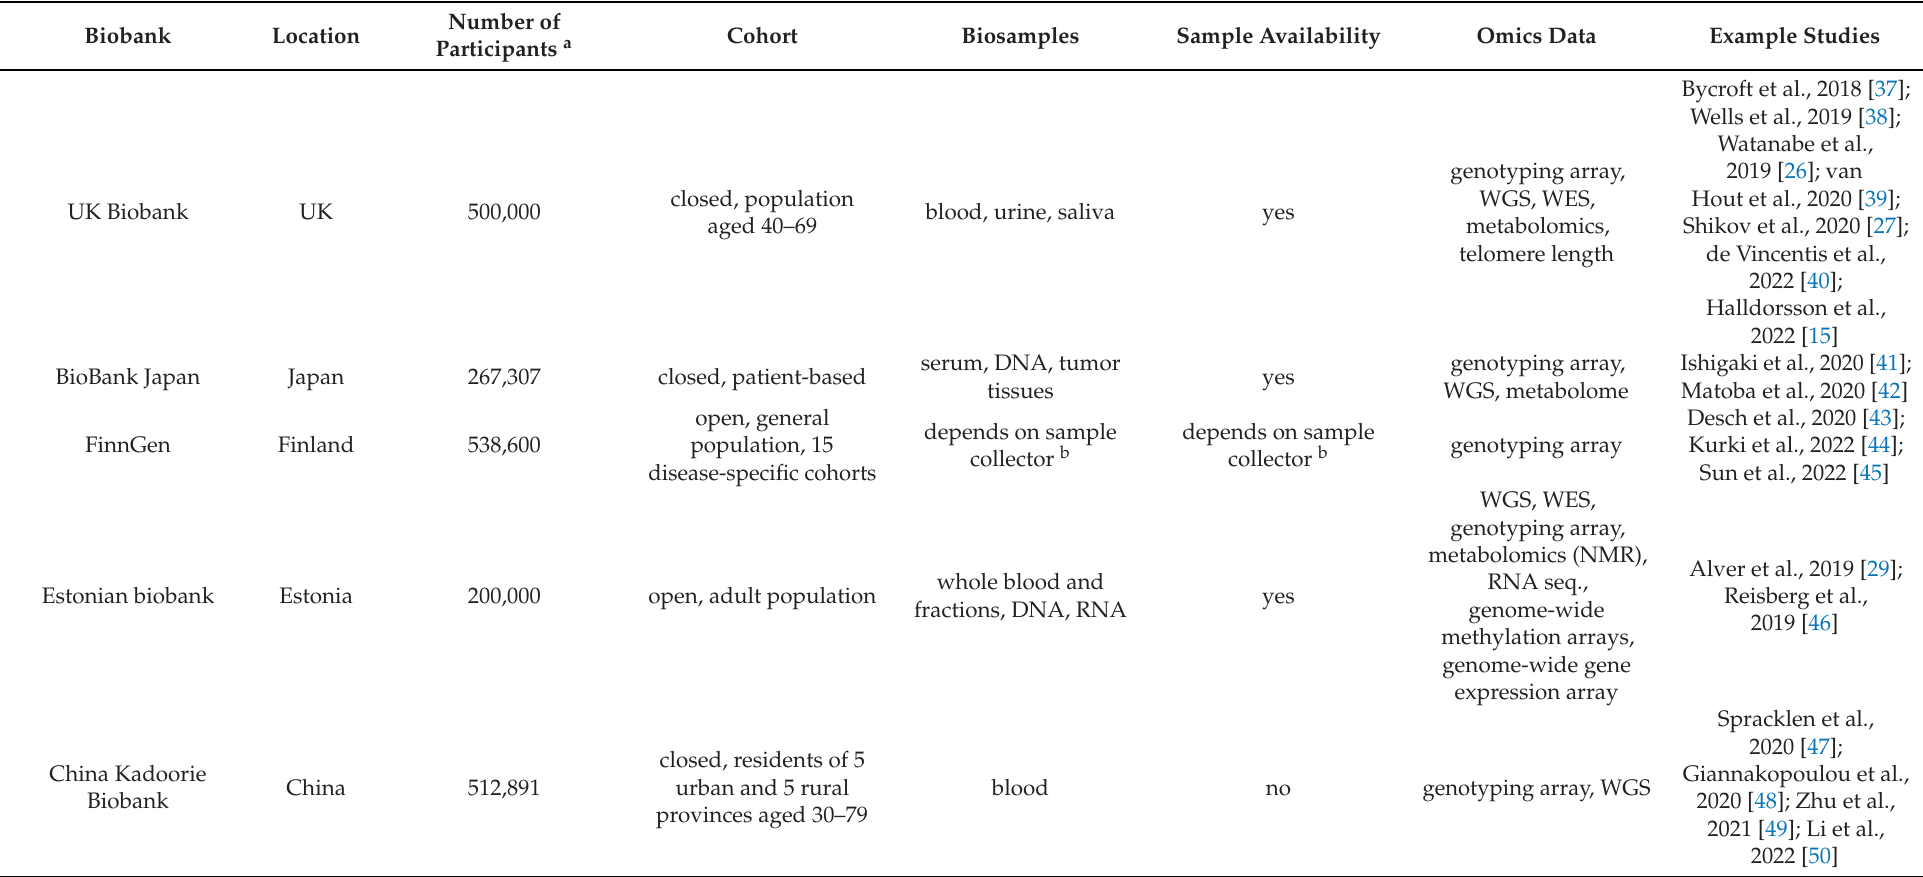
Table 1. Candidate genetic variants associated with COVID-19 related quantitative traits in a cohort of Russian